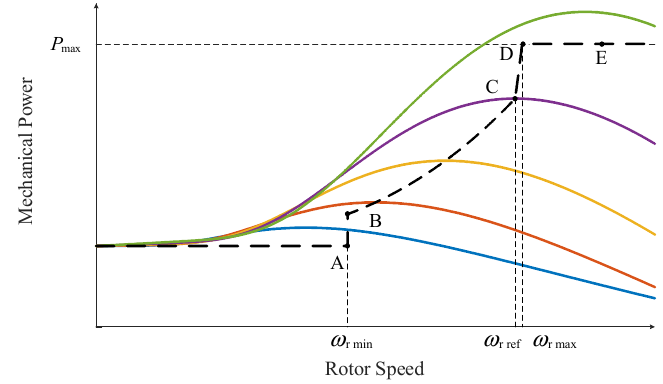
Rotor Speed Figure 1. Mechanical power and the MPPT curves. Figure 1. Mechanical power and the MPPT